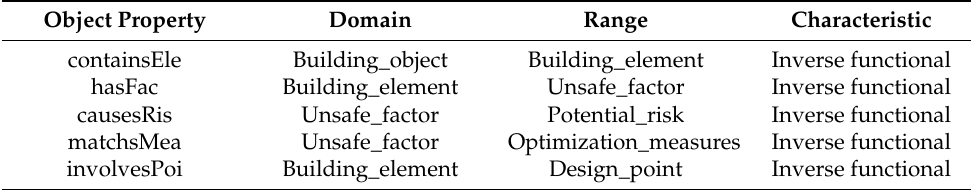
Table 3. Definition of object properties of the DFS ontology.